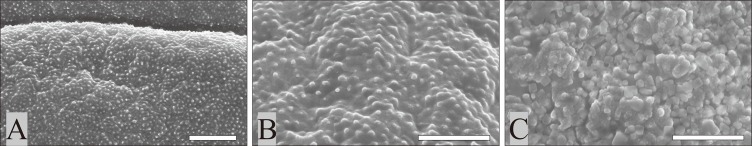
Rodlike masked ornamentations.A and B are from No. 0155–05 sample (corresponding to Fig 2A). C is from No. 0166–3 sample. Scale bar = 2 μm in A, 1 μm in B and C.